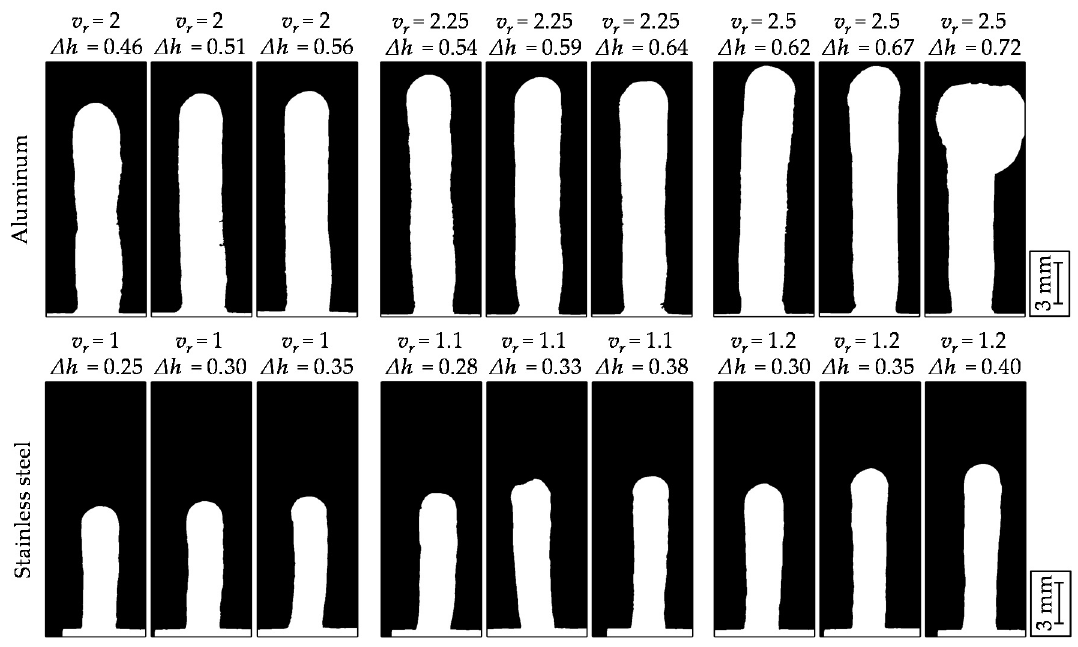
Figure A1. Cross-sectional profiles of the parts produced with different speed ratios and different height increments.